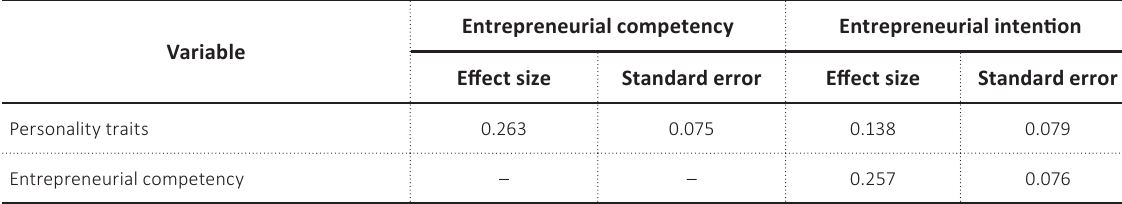
Table 6. Effect size and standard error